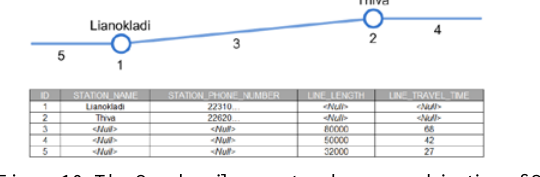
Figure 10. The Greek railway network as a combination of SGO